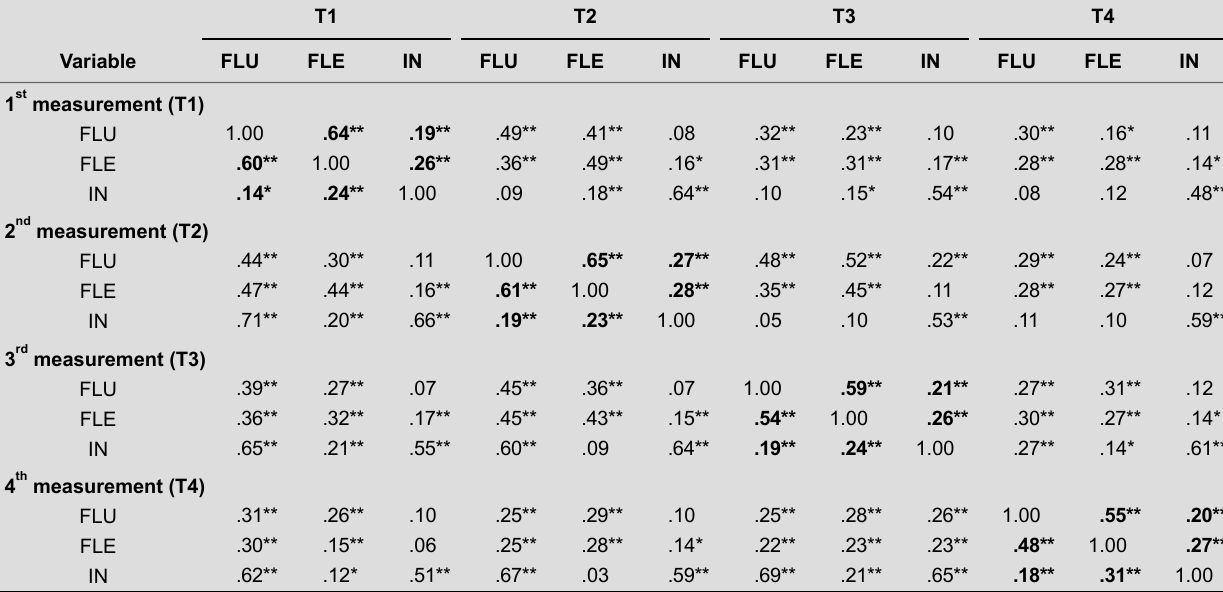
Intercorrelations of Ideational Fluency (FLU), Ideational Flexibility (FLE), and Intelligence (IN) at (in Bold) and Between the Four Times of Measurement in the Luxembourg Sample (Above the Main Diagonal) and in the German Sample (Below the Main Diagonal)